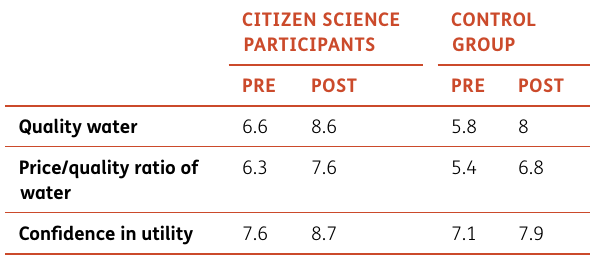
Table 5 Average appreciation scores on a scale from 1 to